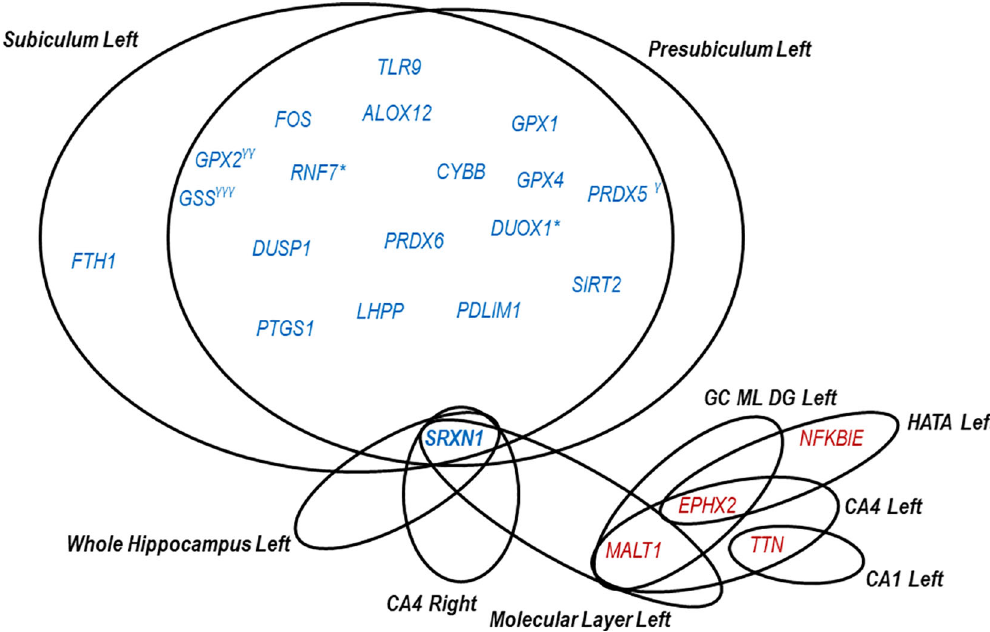
Figure3.RedoxandinflammatorygenessignificantlycorrelatingwithhippocampalsegmentsinCD. Bluefont indicates negative correlations (r<-0.60) and red font positive correlations (r>0.60). *The gene levels correlate (r<-0.60) in subiculumleft bothin CD andNC. γ Correlatesin presubiculum left withr=-0.59. γγ Correlatesin subiculum left with r=-0.55. γγγ Correlates in subiculum left with r=-0.54. Correlations were established using Pearson's corre- lation analysis.